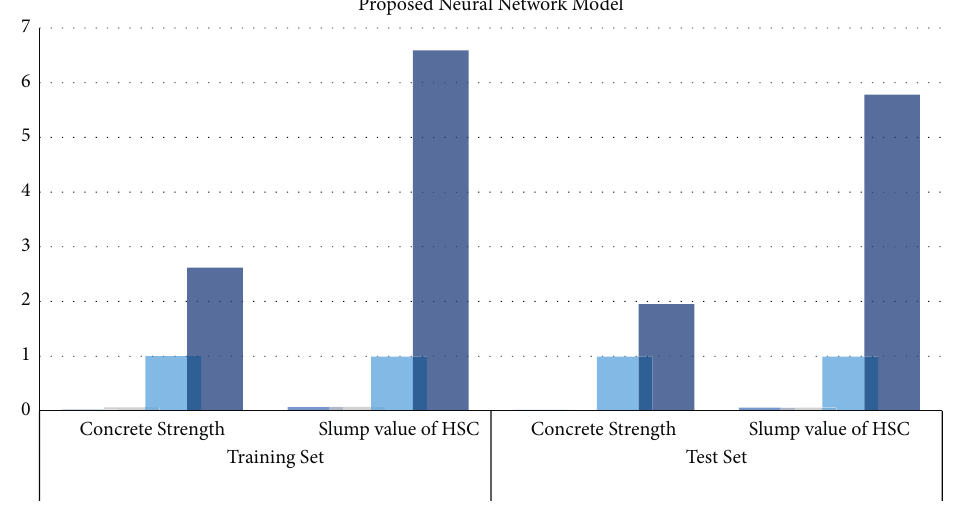
Figure 10: Proposed neural network